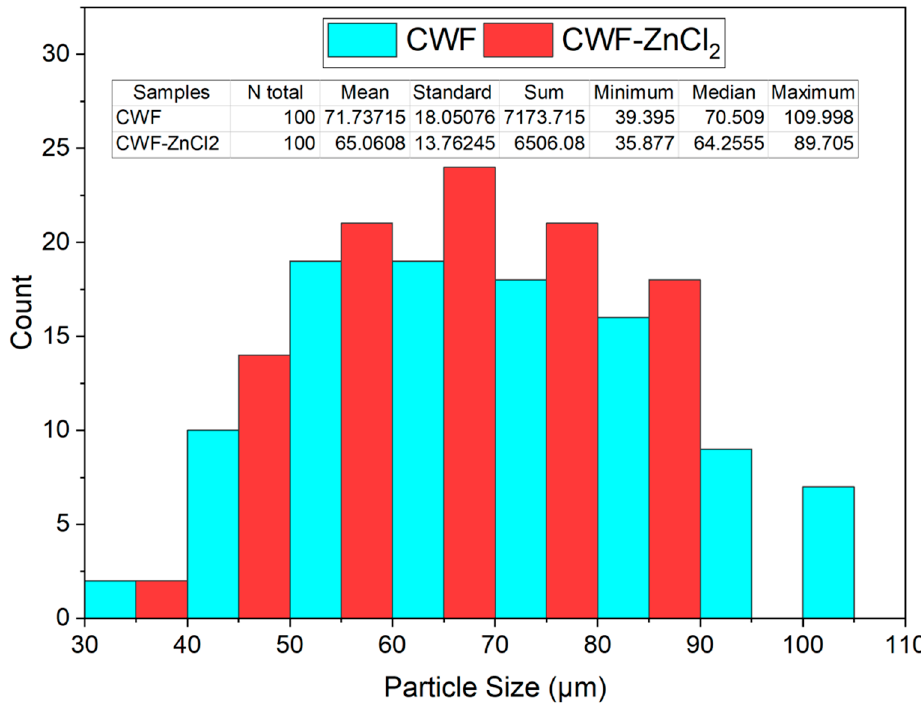
Figure 2. Histogram of particle size distribution of CWF and CWF-ZnCl 2 filler.